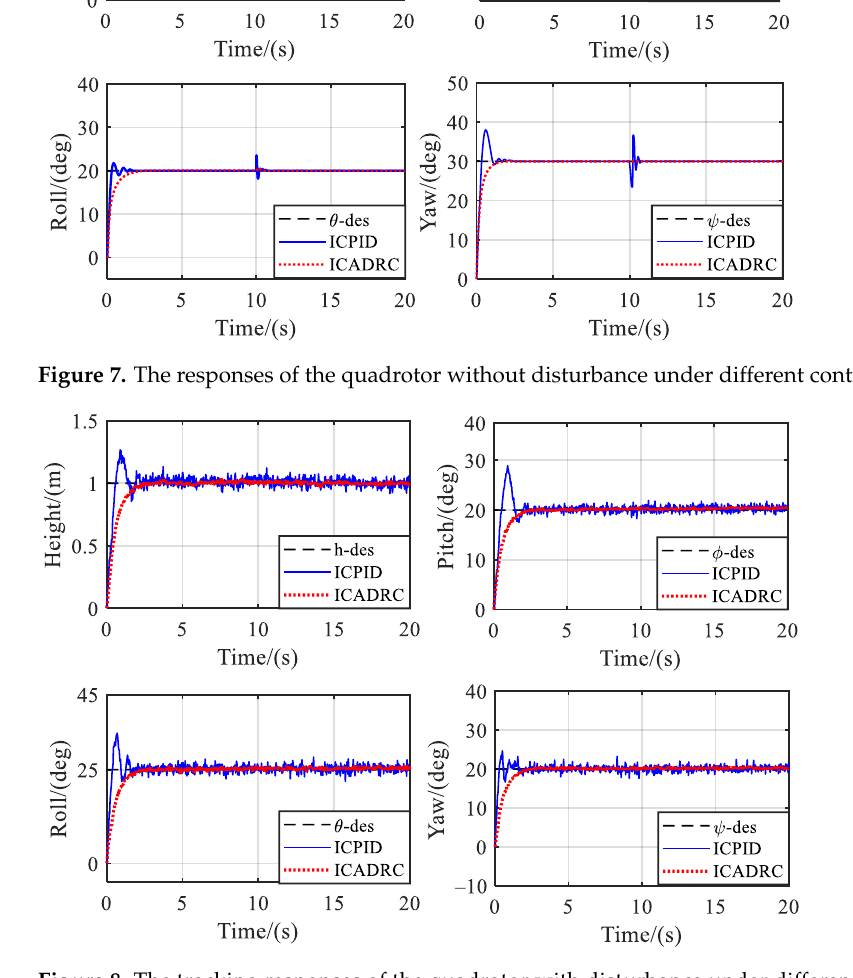
Figure 9. The space trajectories of the quadrotor under different controllers.